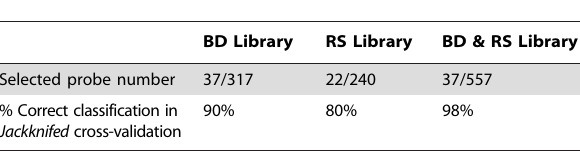
Table 1. LDA results for different fluorescnt probe